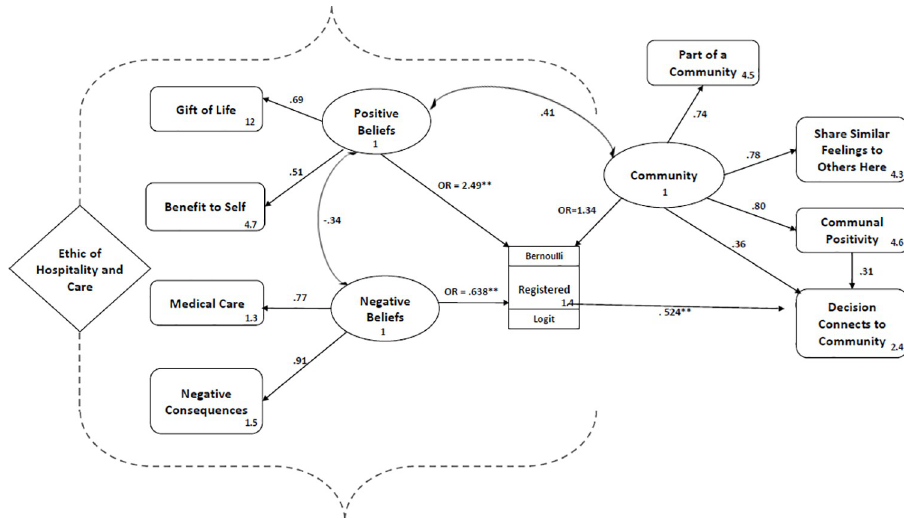
Fig 1. Generalized structural equation model with factor loadings, odds ratios and